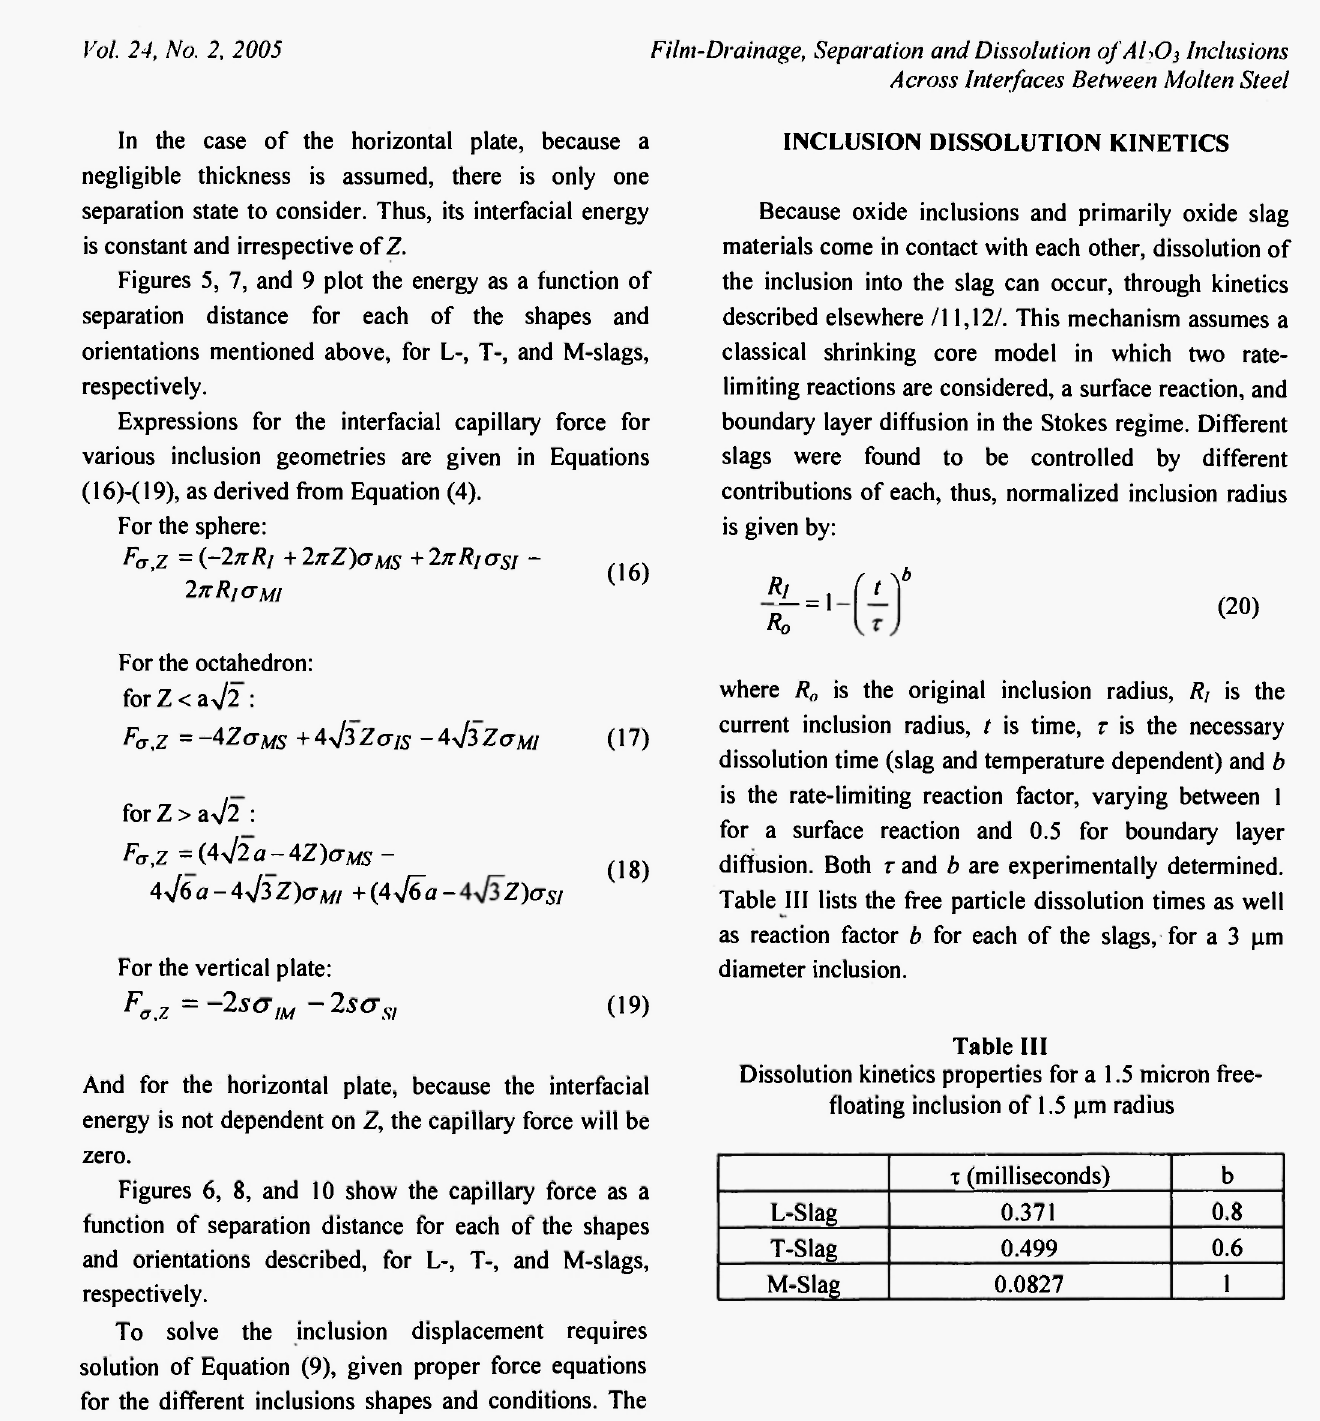
Dissolution kinetics properties for a 1.5 micron